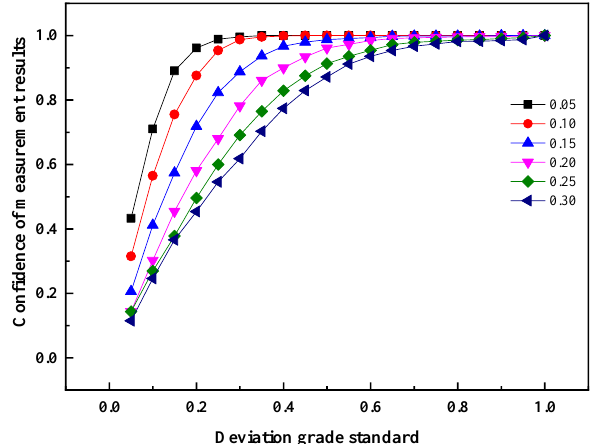
Figure 33. Relationship between deviation grade standard and confidence of measurement results under different relative standard deviation of velocity at mean velocity 2.1 m/s.